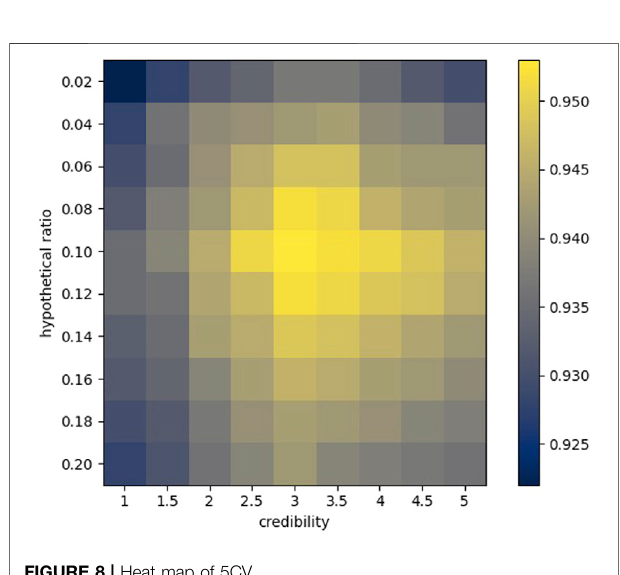
FIGURE 8 | Heat map of